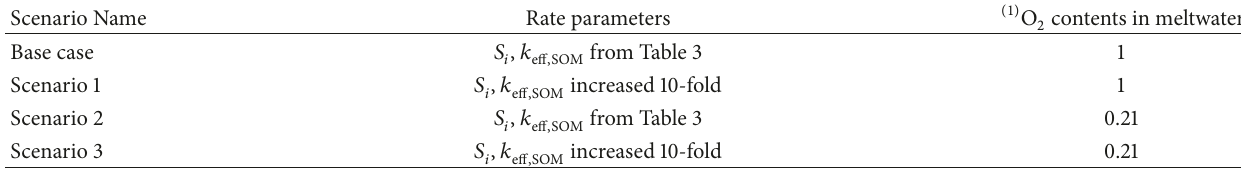
Table 5: Description of the simulation scenarios included in the sensitivity